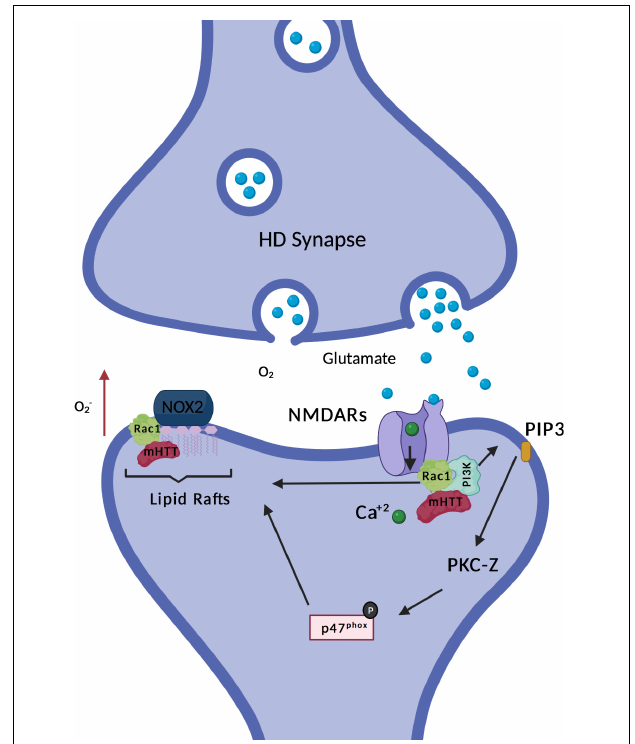
FIGURE 2 | HD and NOX2 interaction. Non-ionotropic activation of PI3K (explained with more details in Figure 3 ) promotes association of p47 phox with the rest of the subunits of NOX2, inducing its enzymatic activation. Mutant Huntingtin (mHtt) is found in complex with Rac1 and PI3K. Expression of mHtt is associated with hyperactive Rac1, which could further contribute to enzymatic activation of NOX2. Moreover, NOX2 is sequestered in lipid rafts together with mHtt, also associated with higher super oxide production, as indicated by the red arrow. The figure here depicts the few data currently available on NOX and HD, it does not illustrates the putative roles of NOX in HD which are discussed in the review.